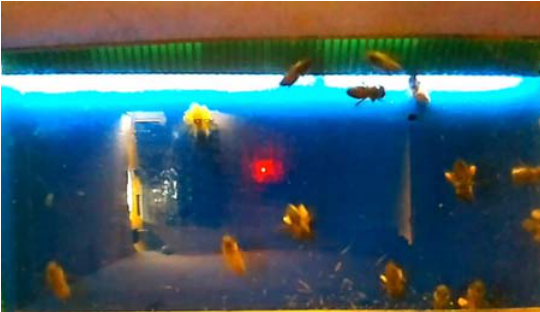
Figure 2. Honey bees in the camera field of view (best viewed in color)